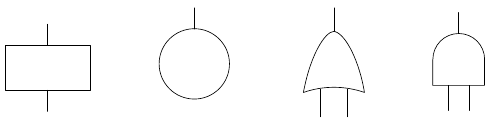
Figure 8. Symbols used in fault trees.